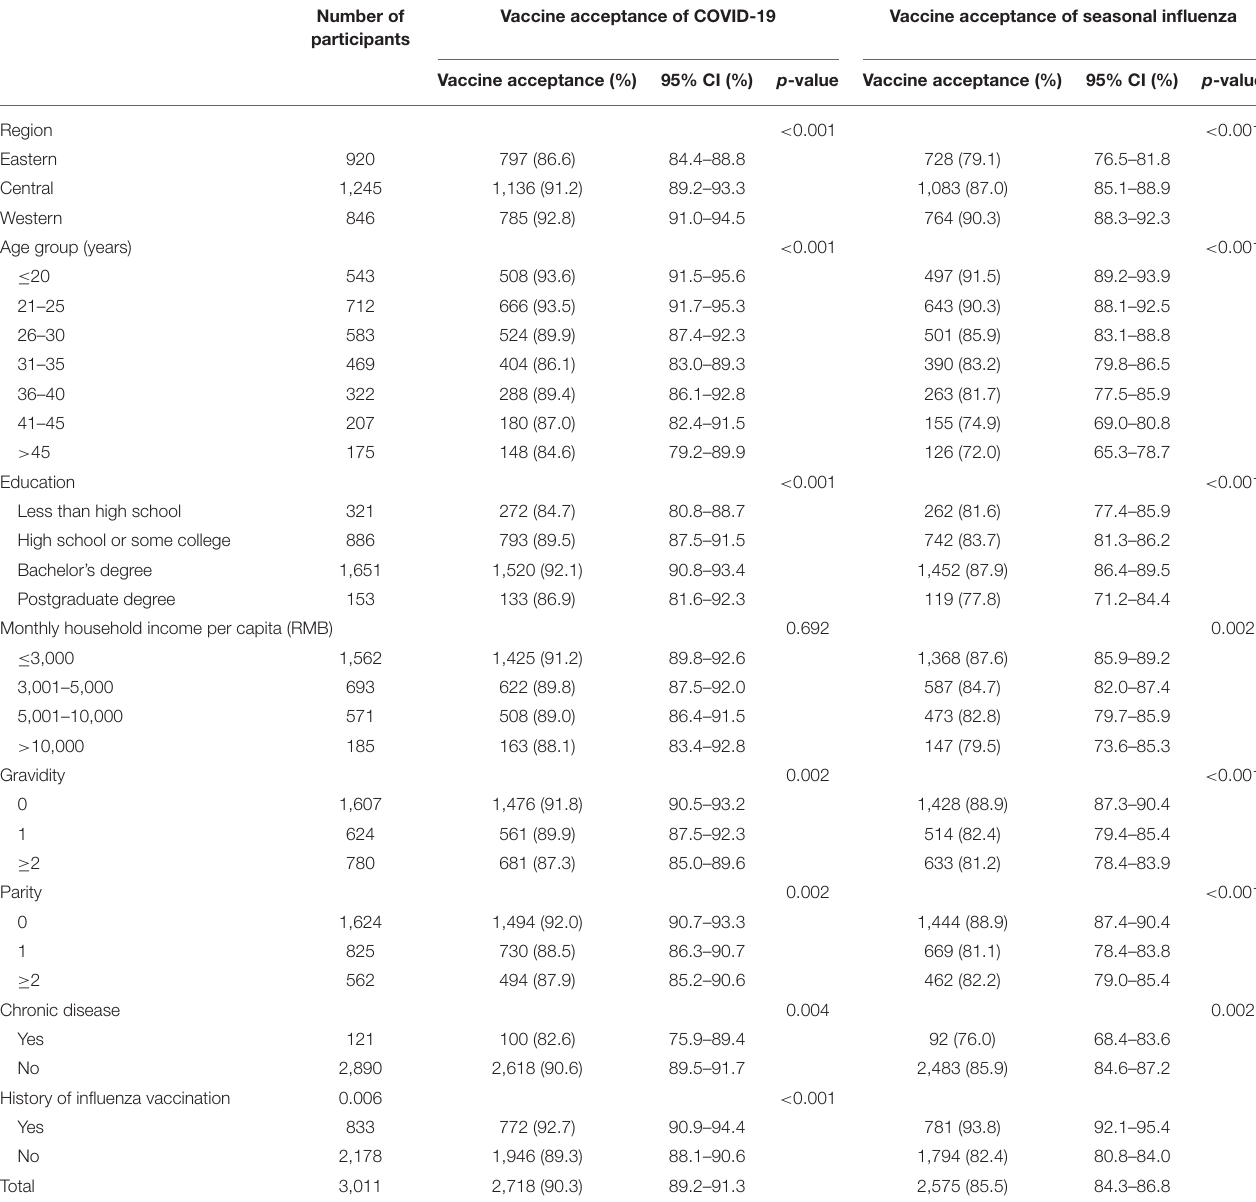
TABLE 1 | Vaccine acceptance of COVID-19 and seasonal influenza among reproductive women aged 18–49 years in China by demographic characteristics. Number of Vaccine acceptance of participants